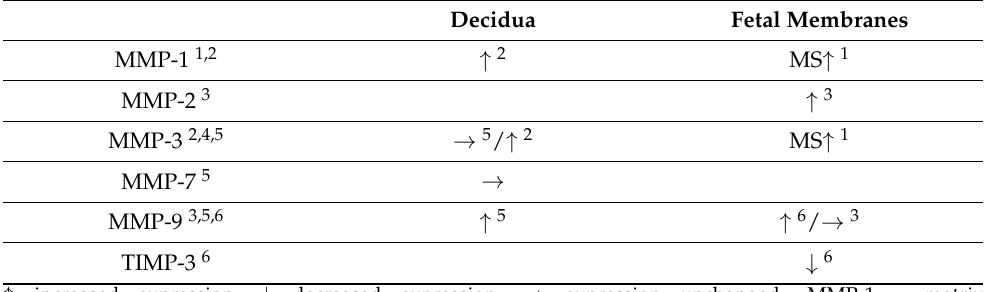
Table 2. Thrombin effects on MMP